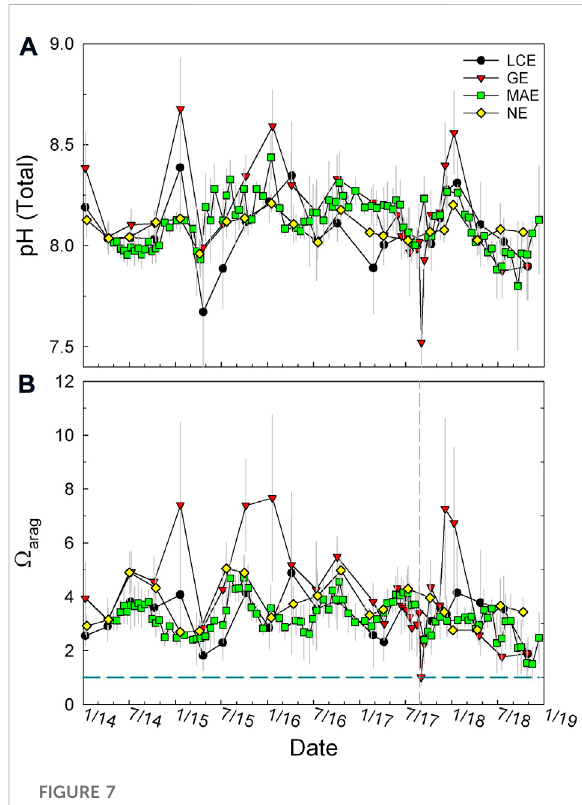
FIGURE 7 pH on a total scale (A) and Ω arag (B) in the four studied estuaries during 2014 – 2018. Note in calculating Ω arag , samples with S < 5 were not included as the solubility constant of aragonite (Mucci, 1983) is valid for salinity 5 – 44. These values are averages of all data from these stations as strati fi cation occurred